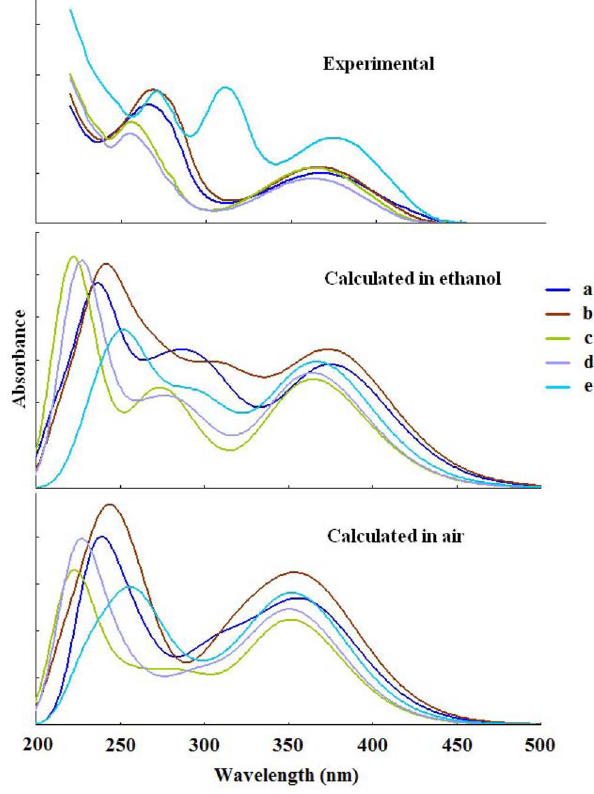
Figure 7. Experimental and calculated UV-vis spectra of a–e.